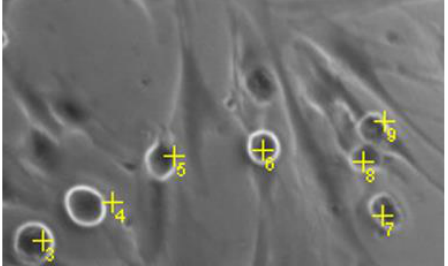
Figure 8. Quantification of round cells. Numbers representing cell count of round cells.